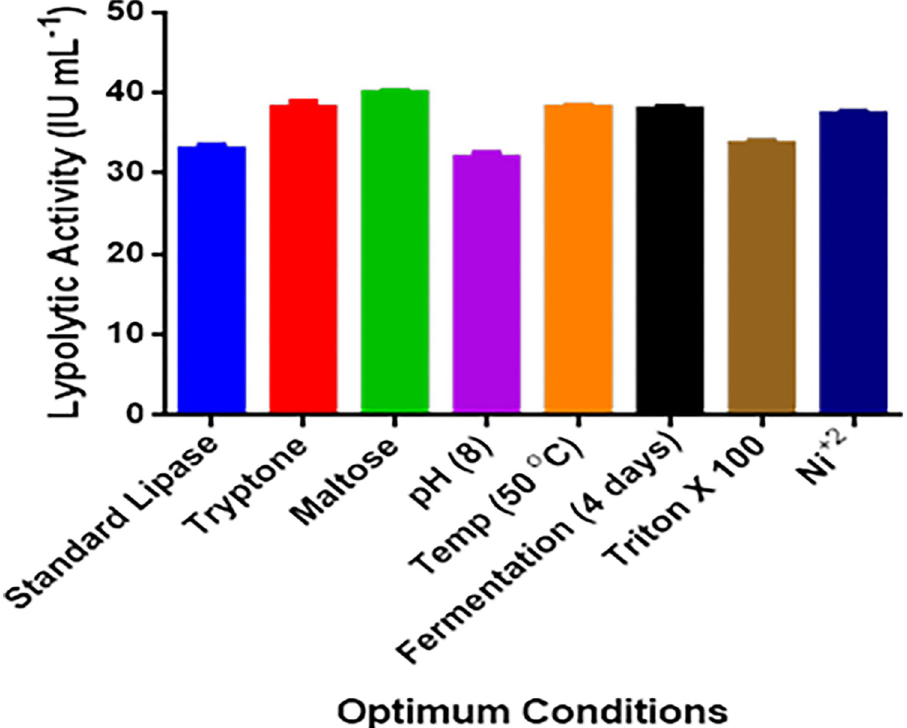
Fig 4. Statical analysis of different optimum conditions by applying one-way ANOVA.